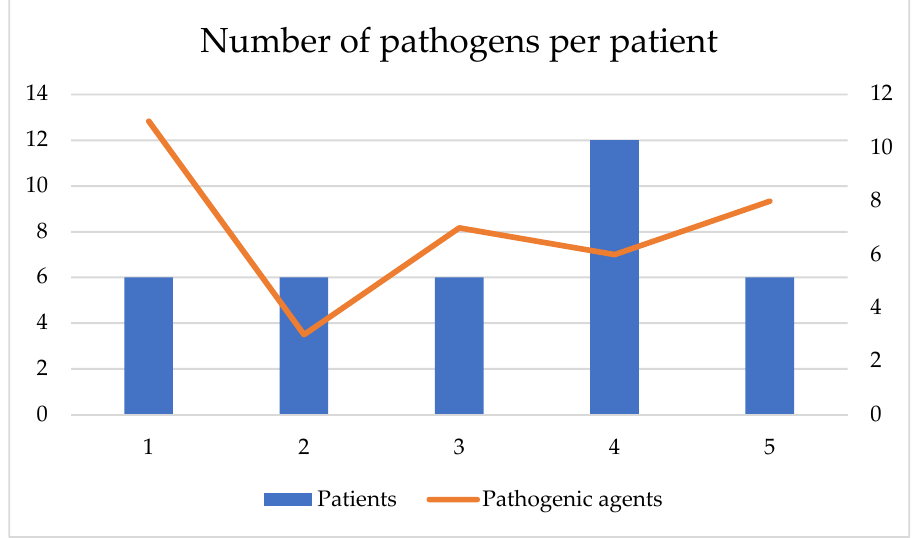
Figure 4. Graphic presentation of the correlation of patients with the number of pathogens per pa- tient.